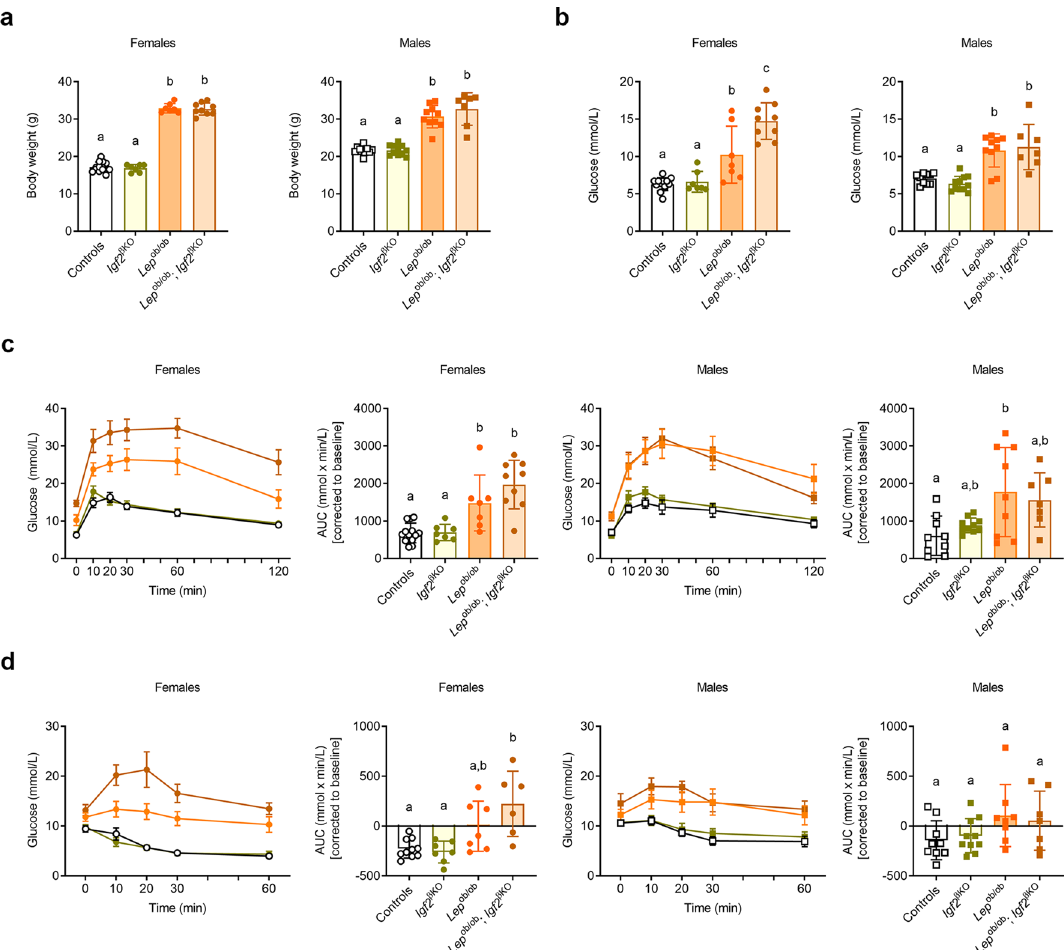
Figure 5. Impact of Igf2 βKO on body weight and glucose homeostasis in Lep ob/ob in 8 week old male and female mice ( a ) Body weights. ( b ) Glucose levels in peripheral blood measured after overnight fasting. ( c ) ipGTTs performed after overnight fasting. First and third graphs show changes in blood glucose concentrations (y-axis), from basal pre-treatment values, with time (x-axis), after glucose administration. Second and fourth graphs show AUCs, calculated during ipGTT using the trapezoid rule, normalised to basal glucose levels. ( d ) ITTs performed after overnight fasting. First and third graphs show changes in blood glucose concentrations (y-axis), from basal pre-treatment values, with time (x-axis), after insulin administration. Second and fourth graphs show AUCs, calculated during ITT using the trapezoid rule, normalised to basal glucose levels. For all graphs, data is presented as individual values, with averages ± SD [panels ( a ) and ( b ) and second plus fourth graphs in panels ( c ) and ( d )] or as averages ± SEM [first and third graphs in panels ( c ) and ( d )]; n = 6–10 mice/group. Different letters indicate significant differences between groups ( P < 0.05 by Tukey’s post hoc test following one ‐ way